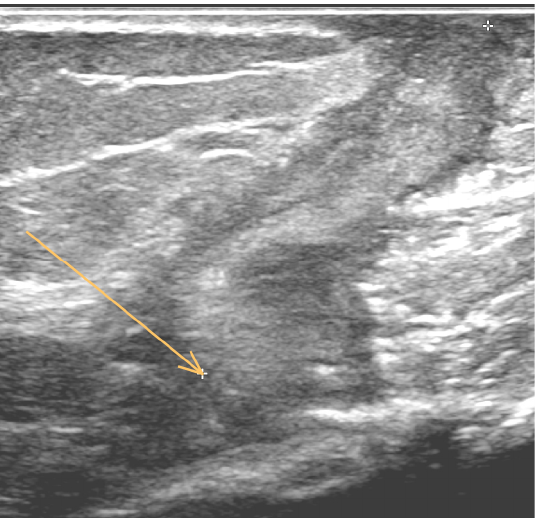
Figure 1. Ultrasound examination of the proximal part of the right arm shows a fluid-thickened collection (indicated by arrow).